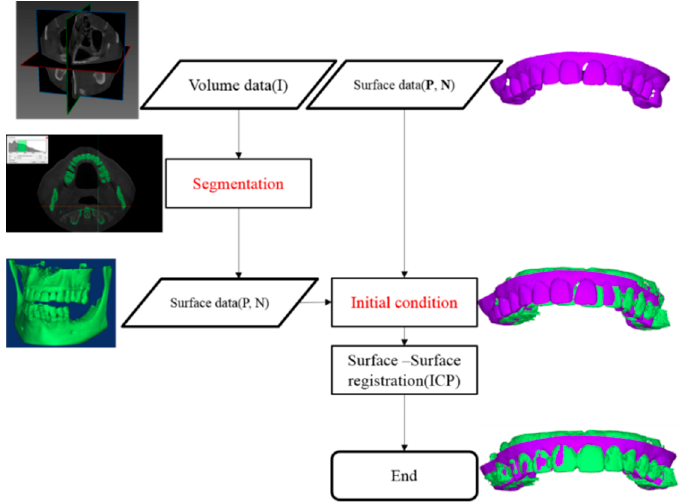
Figure 1. Flow chart: the iterative closest point (ICP)-based method, the established registration method.